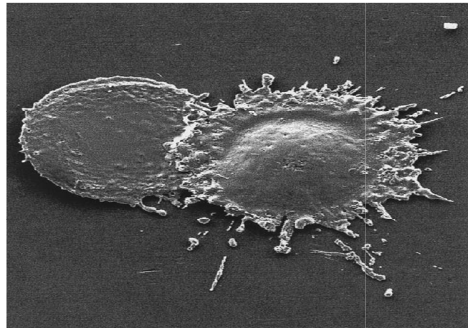
Fig. 1. Splashing of molten tin droplet on a stainless steel surface